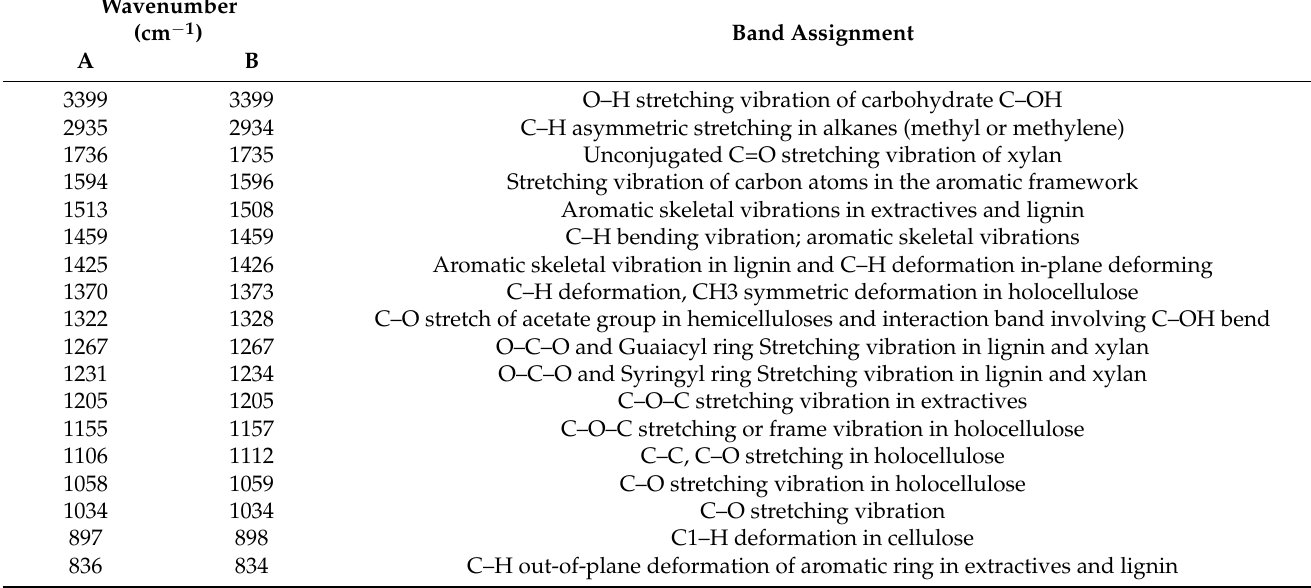
Figure 1. Fourier transform infrared spectroscopy (FTIR) spectra of pterocarpus bracelet (PB) ( A ) and P. santalinus ( B ). Table 1. The main characteristic Fourier transform infrared spectroscopy (FTIR) bands of